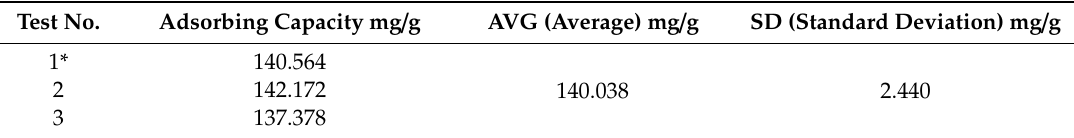
Table 6. The verification test results.